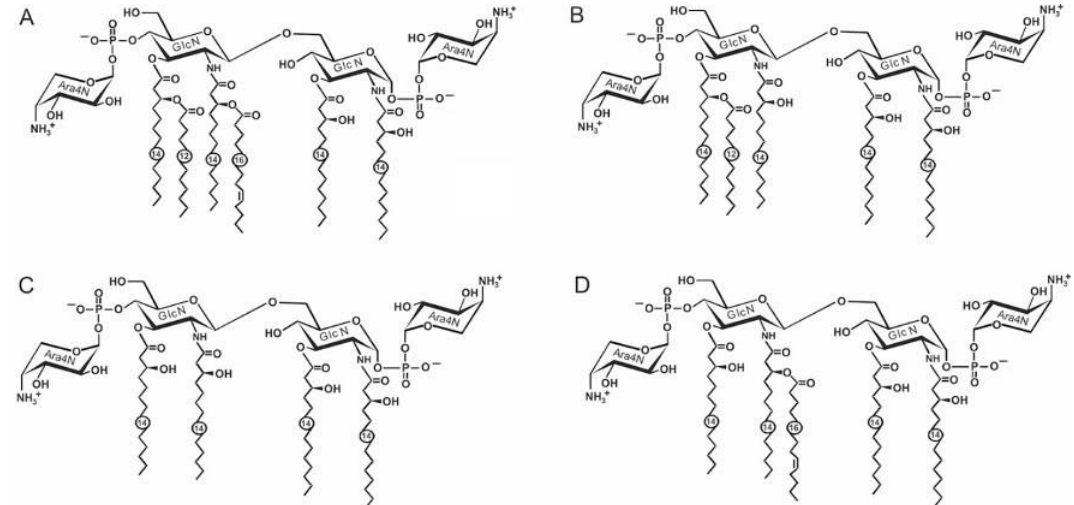
Figure 1. Structures of hexaacyl ( A ), pentaacyl ( B ) and tetraacyl ( C , D ) lipid A species of Y. pestis and Y. pseudotuberculosis. In tetraacyl lipid A of Y. pestis ( C , D ), Ara4N is present in a non-stoichiometric amount at 37° or completely absent at 6 °C , respectively.